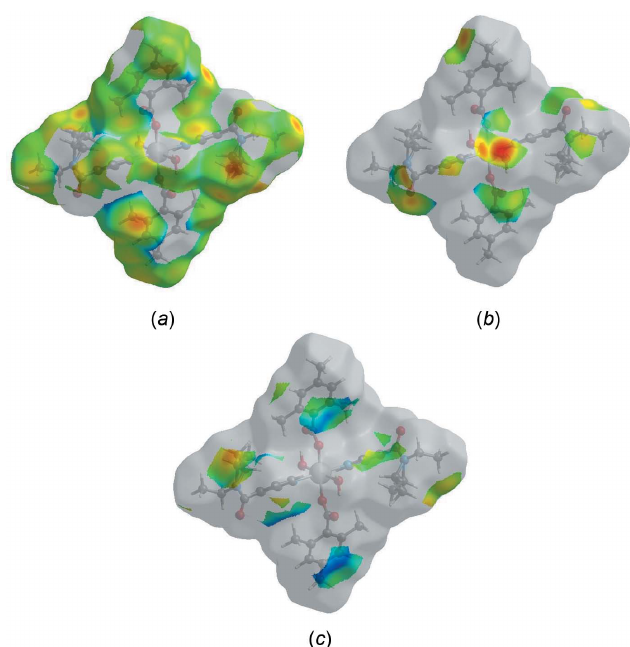
Figure 7 The Hirshfeld surface representations with the function d norm plotted onto the surface for ( a ) H (cid:3)(cid:3)(cid:3) H, ( b ) H (cid:3)(cid:3)(cid:3) O/O (cid:3)(cid:3)(cid:3) H and ( c ) H (cid:3)(cid:3)(cid:3) C/C (cid:3)(cid:3)(cid:3) H interactions.